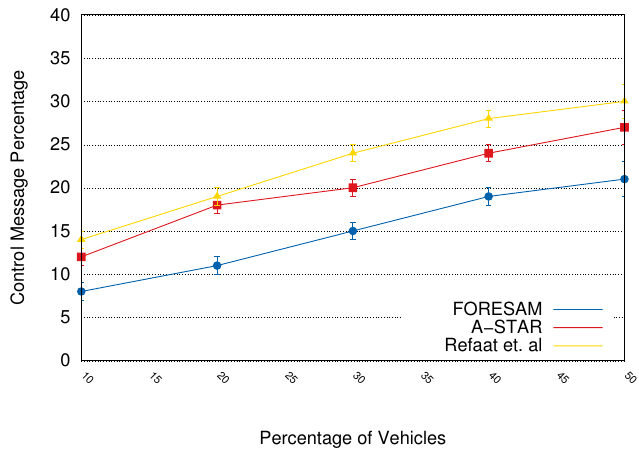
Figure 6. The percentage of control messages.